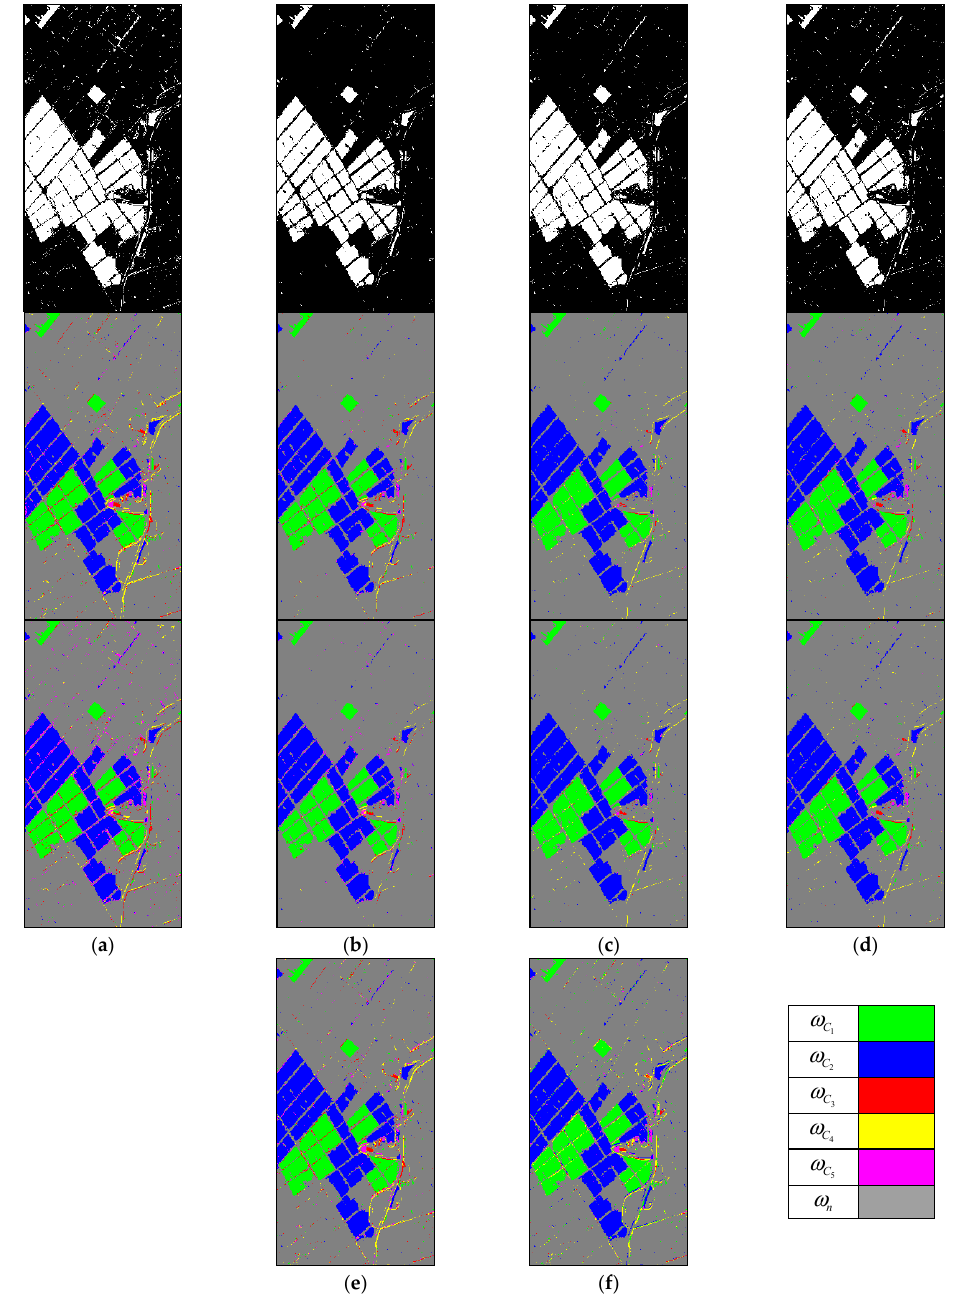
Figure 11. Binary (row 1–2) and multiple (row 3–5) CD maps obtained by the proposed CD approaches (Yancheng dataset). The unsupervised approaches: ( a ) Bayesian-EM (or k -means for multiple CD); ( b ) FCM. The supervised approaches: ( c ) SVM-based and ( d ) RaF-based. Rows 1 and 3 are baseline results on X D , and rows 2 and 4 are results on X S with M = 20; ( e ) HSCVA; ( f ) S 2 CVA.